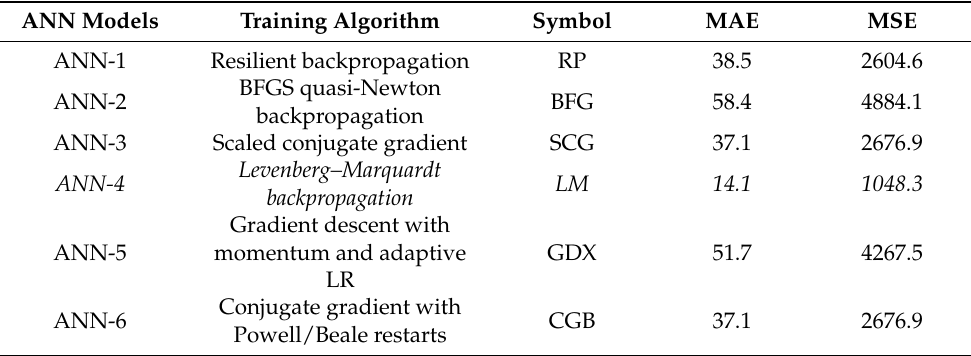
Table 7. The effect of the training algorithm on the performance of the six ANN models executed with four neurons in the hidden layer architecture.